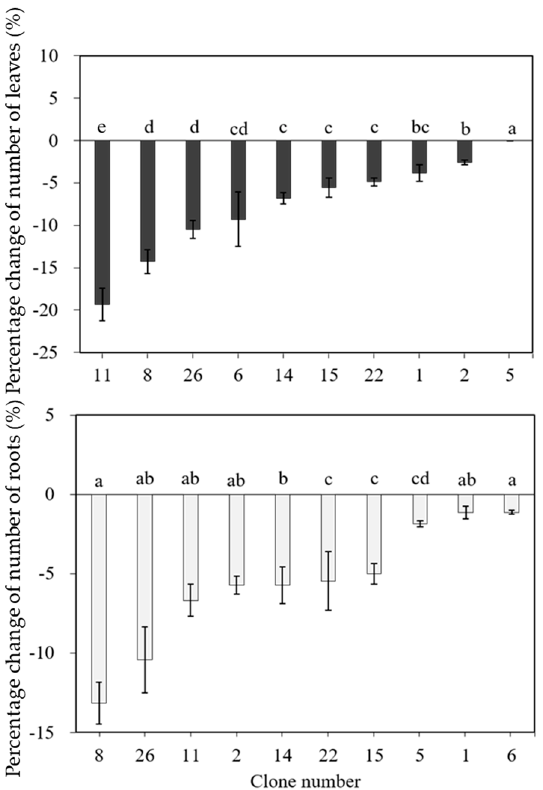
Figure 3. Effect of high-temperature treatment (32.5 °C) on the number of leaves and roots in various clones of Cnidium officinale. Different letters indicate mean values which are significantly different at p < 0.05 according to Duncan’s multiple range test ( n = 10).